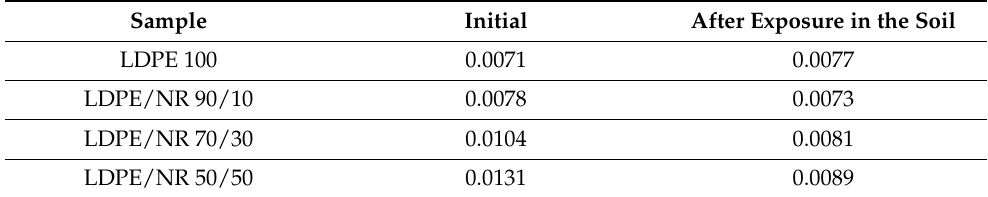
Table 7. Changing the length of the lamellae after 24 months of exposure in